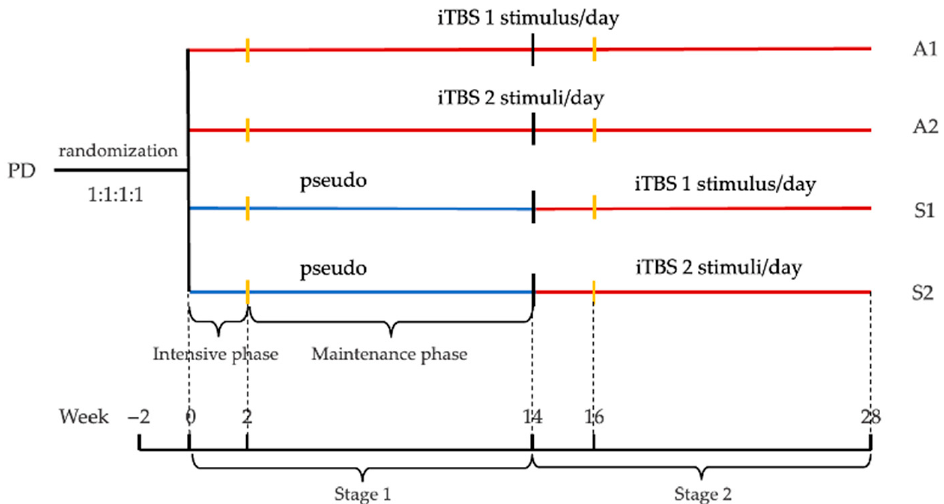
Figure 1. Schematic representation of study outline and visits. Stage 1 = pseudo-controlled stage, Stage 2 = active treatment stage; Phase 1 = intensive phase, Phase 2 = maintenance phase; A1 = early-start single iTBS group, A2 = early-start double iTBS group, S1 = delayed-start single iTBS group, S2 = delayed-start double iTBS